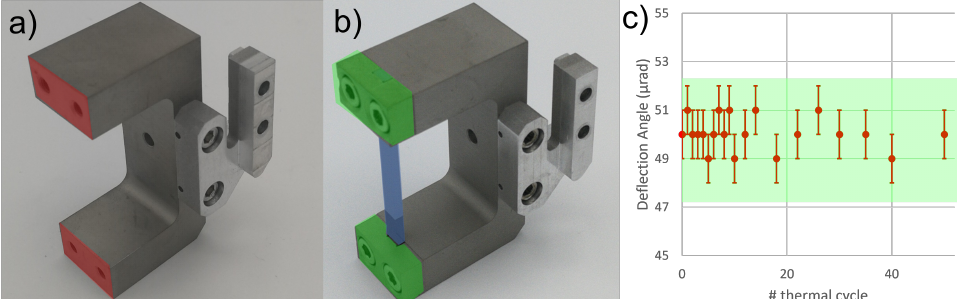
Figure 12. ( a ) Picture of holder for LHC collimation, the highlighted red surfaces are inclined. ( b ) A silicon sample (highlighted in blue) is mounted on the red surfaces by clamps (highlighted in green) in order to force an arched shape. ( c ) channeling bending angle is measured after each bake-out process to confirm the assembly stability (light green zone is accepted range for LHC collimation). More details can be found in [71].